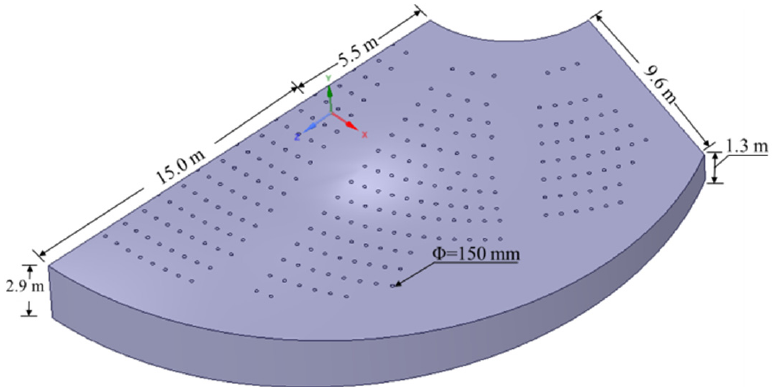
Figure 2. Schematic diagram of the UFAD system. ( a ) vertical section of plenum under centralized air supply, ( b ) vertical section of plenum under uniform air supply, ( c ) layout of centralized air supply, and ( d ) layout of uniform air supply (dashed box represents the simulated zone).